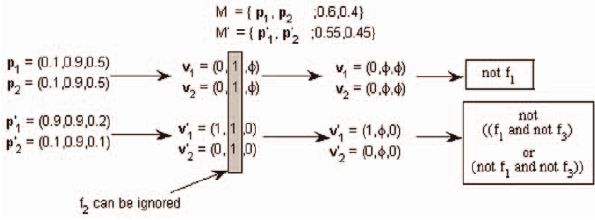
Figure 3. Generation of rules and feature selection [ 32 ] . The first arrow indicates the mapping of probability vectors to main vectors and the second arrow shows the elimination of some features which have zero variance. The boxes on the extreme right contain the derived rule. The first rule is a negation as it is derived from target values equal to zero.